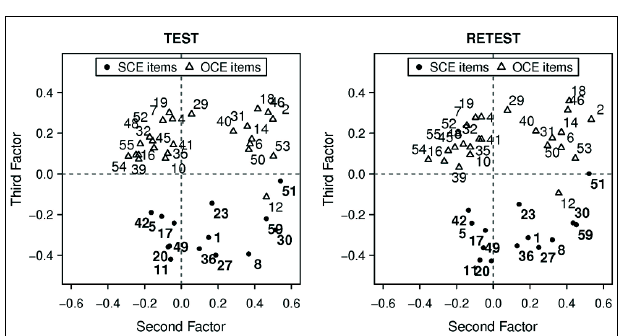
FIGURE 2 | Item loadings on the second and third factorial axes. The points represent the selected Self-centric engagement (SCE) items and Other-centric engagement (OCE) items respectively, forming two separated clusters.The proximity of the points of each cluster reveals a pattern of correlation of the projections of items on the